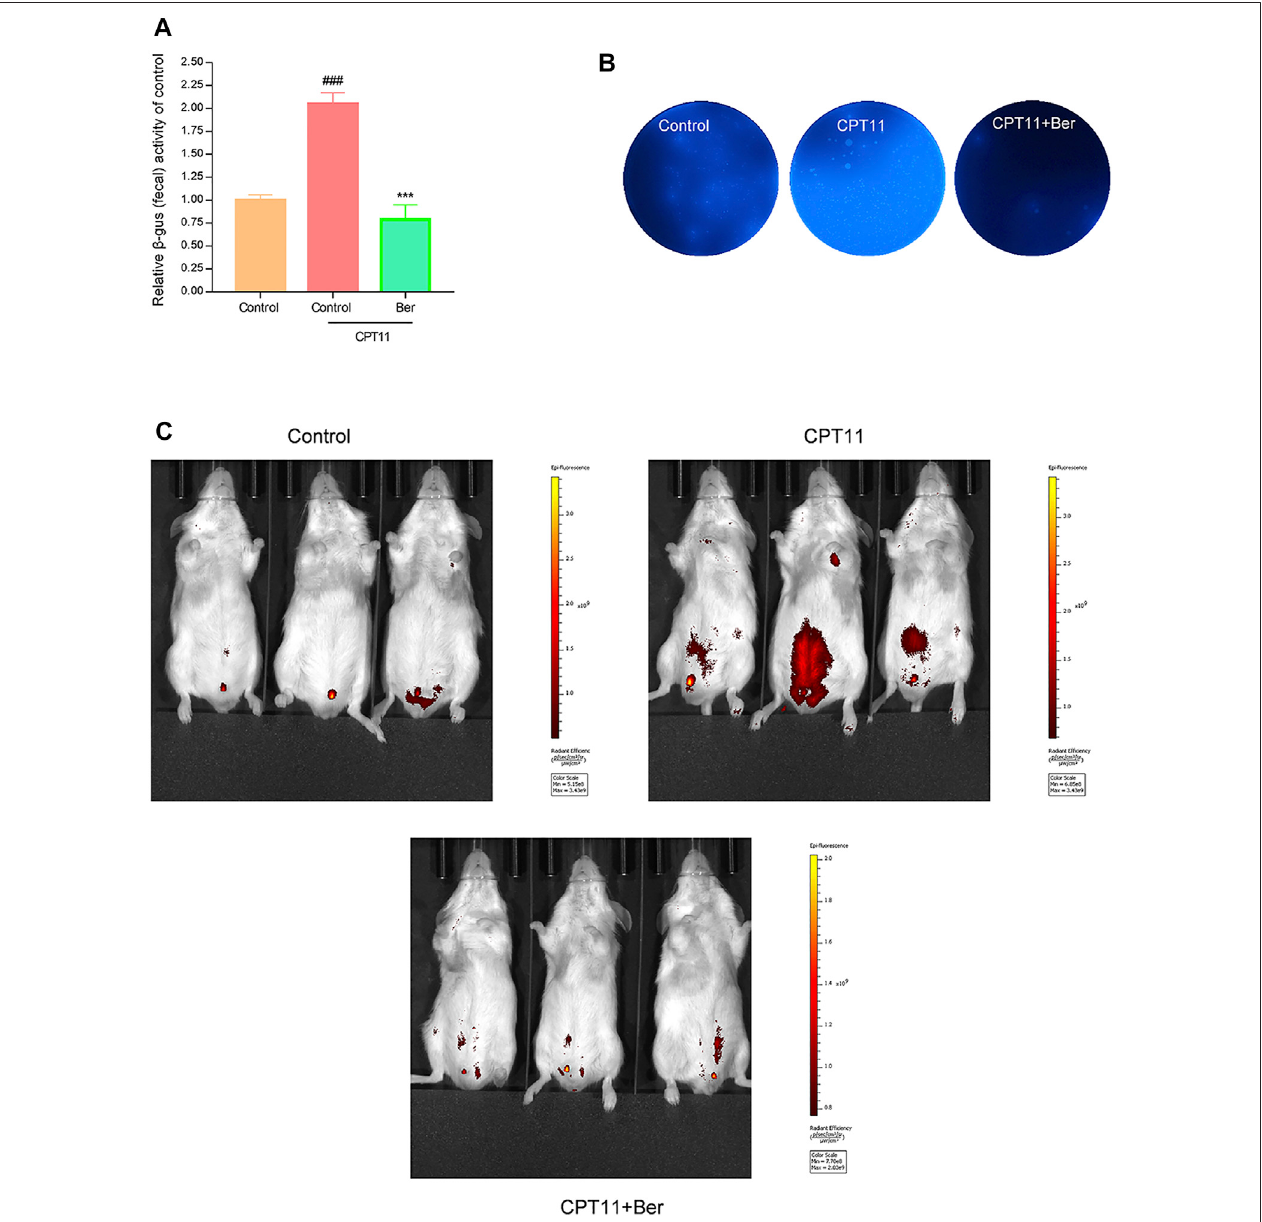
FIGURE 5 | Berberine inhibited intestinal GUS activity. (A) Fecal pellets were collected to evaluate the GUS activity in mice after CPT11 and CPT11 + berberine treatmentby4-MUGassay. (B) TheassessmentoffecalpelletsforGUS-producingbacteriawasdeterminedbyculturewith4-MUGagarmedium. (C) Miceweretreated withCPT11orCPT11+berberinefor14 days;GUSactivitywasthenimagedusingthe fl uorescentsubstrateFDGlcU.Datawereexpressed asthemean ± SD( n (cid:2) 3per group). ## p < 0.01, ### p < 0.001 vs. the control group; ** p < 0.01, *** p < 0.001 vs. CPT1 + berberine treated group.